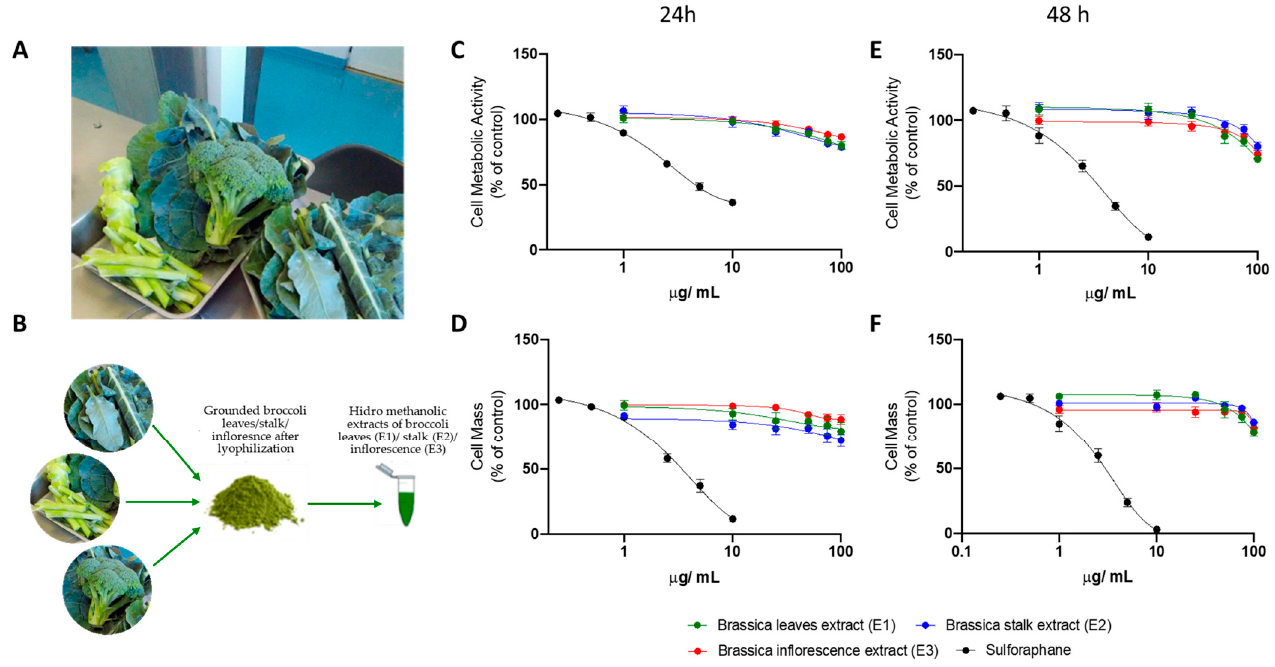
Figure 1. Cytotoxicity of Brassica oleracea var italica extracts in HepG2 cells, using different concentrations and for 24 or 48 h. ( A ) Photo of the plant broken down into leaves, stalks and inflorescences.( B ) Preparation of broccoli leaf, stalk, and inflorescence extracts. HepG2 cells were seeded and then treated with increasing concentrations of leaf (E1—green), stalk (E2—blue), or inflorescence (E3—red) Brassica extracts and sulforaphane (black) for 24 h or 48 and their cytotoxic effects were evaluated through variations in cell metabolic activity ( C , E ) and cell mass ( D , F ). Data are the mean ± SEM of the three different assays performed, and the results are normalized on the control condition (CTL = 100%). The data obtained with BBP extracts were compared to CTL using a one-way ANOVA with Dunnett’s multiple comparison post-test. Table 1. Total phenols (mg GA/g DW), ortho-diphenols (mg GA/g DW), and flavonoids (mg CAT/g DW) content and antioxidant activity (mmol Trolox/g DW) of broccoli leaves, stalks, and